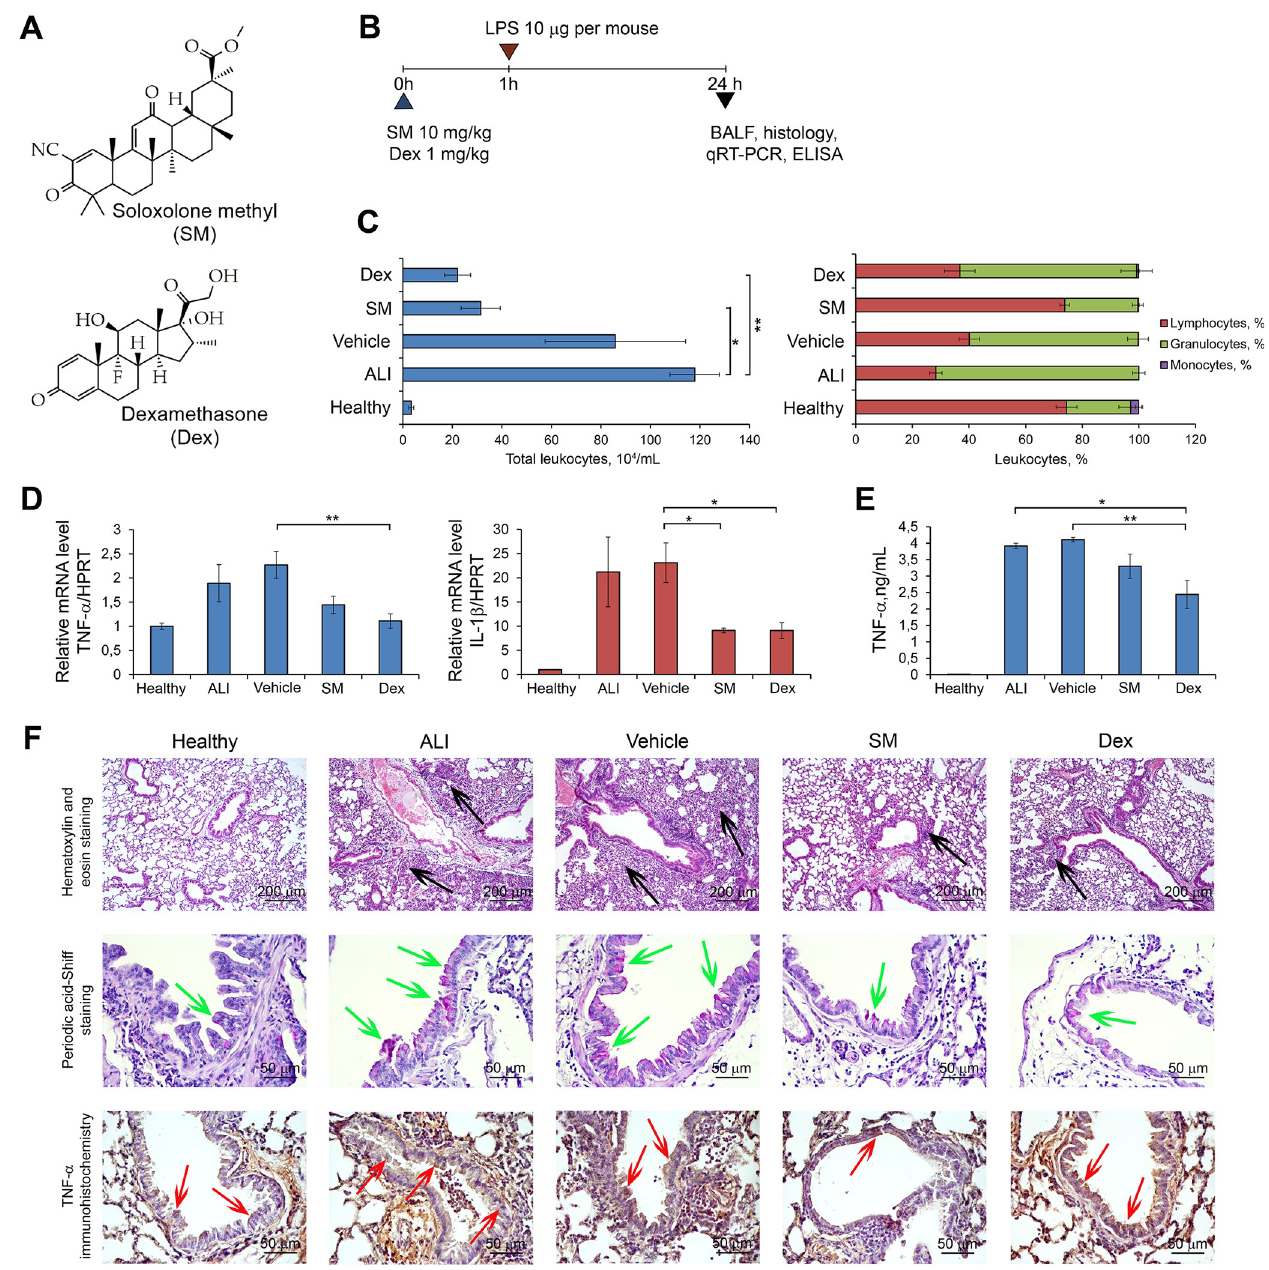
Fig 2. Soloxolone Methyl (SM) and dexamethasone (Dex) effectively ameliorate Acute Lung Injury (ALI) in vivo . ( A ) The chemical structures of SM and Dex. ( B ) The experimental setup. SM (10 mg/kg) and Dex (1 mg/kg) were administered to mice 1 h prior to LPS instillation (10 mg per mice), followed by the evaluation of ALI 24 h after the induction of lung inflammation. ( C ) Total (left) and differential (right) leukocyte counts in the bronchoalveolar (BAL) fluid of healthy and LPS-challenged mice receiving SM or Dex therapy. Total leukocyte counts were estimated using a Neubauer chamber. The distribution of leukocyte subpopulations was measured by microscopy after staining of cells with azur-eosin by Romanovsky-Giemsa. ( D, E ) The levels of pro-inflammatory cytokines (TNF- α and IL-1 β ) in the lung tissue measured by qRT-PCR and BAL fluid measured by ELISA. ( F ) Representative histological images of lung sections of healthy and LPS-challenged mice receiving SM or Dex therapy. Haematoxylin and eosin staining, original magnification × 100 (upper panel), periodic acid-Schiff staining, original magnification × 400 (middle panel), and immunohistochemical staining with anti-TNF- α primary antibodies, original magnification × 400 (bottom panel). The black arrows indicate inflammatory infiltration, the green arrows indicate mucus hyperproduction, and red arrows indicate TNF- α hyperexpression in lung tissue.